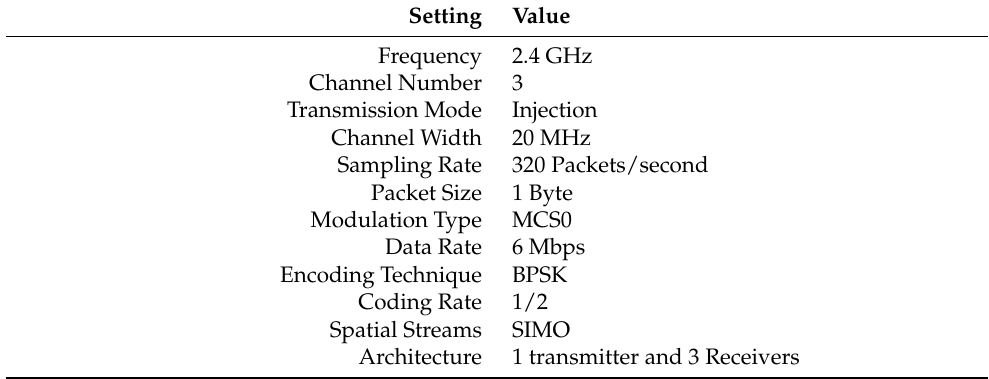
Table 1. Transmitter and receiver settings.